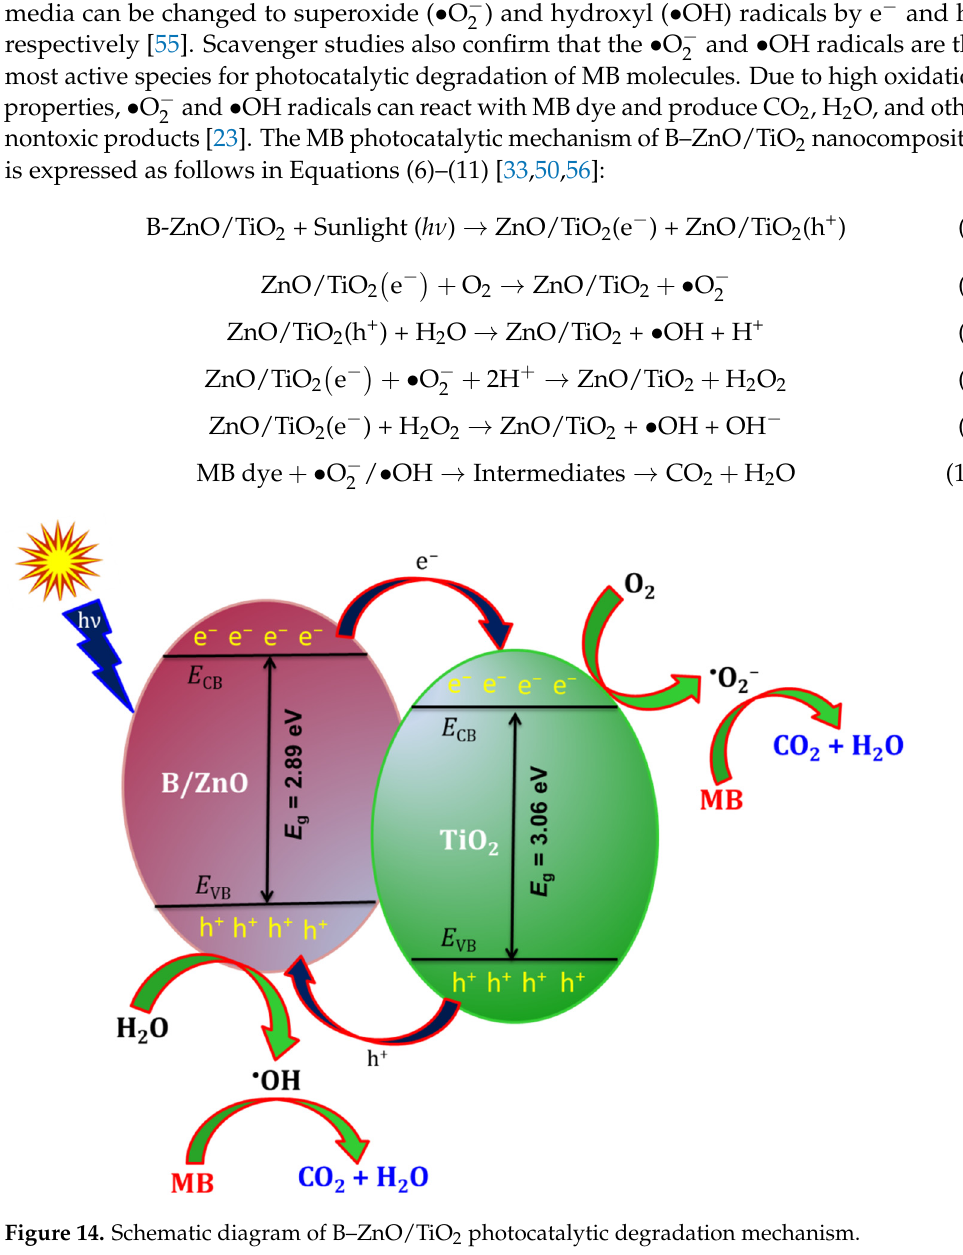
Figure 14. Schematic diagram of B–ZnO/TiO 2 photocatalytic degradation